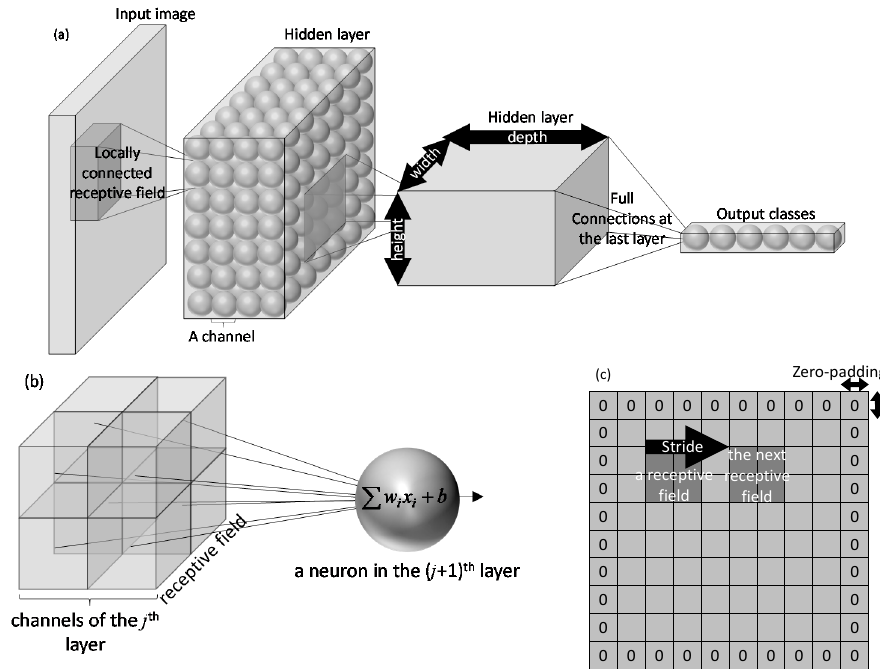
Figure 2. Convolutional neural networks: ( a ) conceptual architecture, ( b ) a neuron with a 2 × 2 receptive field on a two-channel layer, and ( c ) zero-padding and stride on a channel.